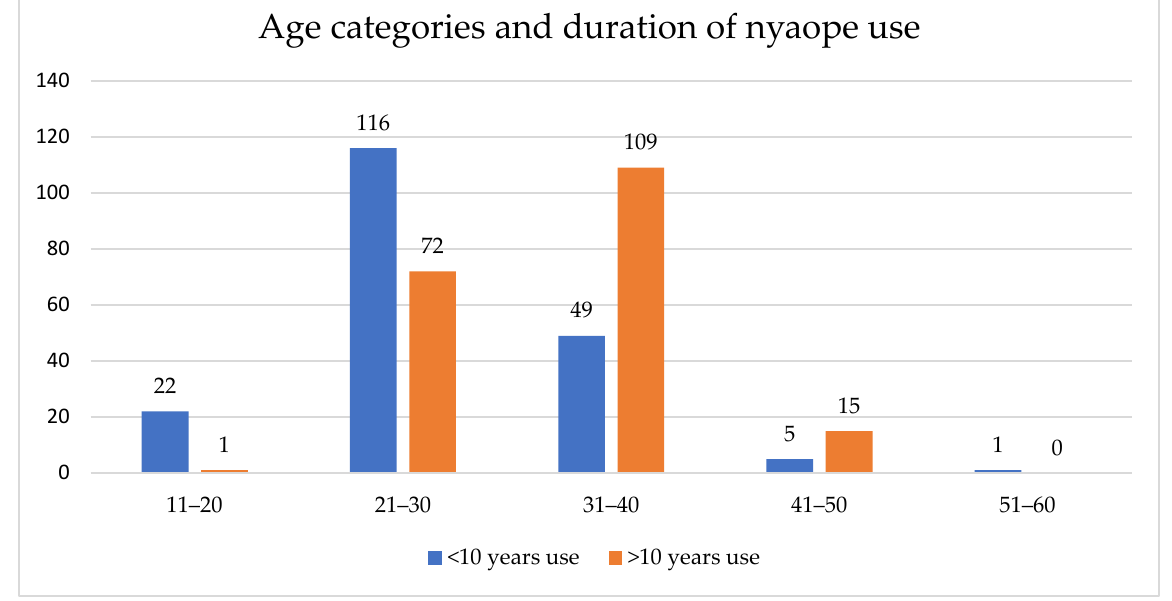
Figure 1. Duration of use by the age groups of the users.